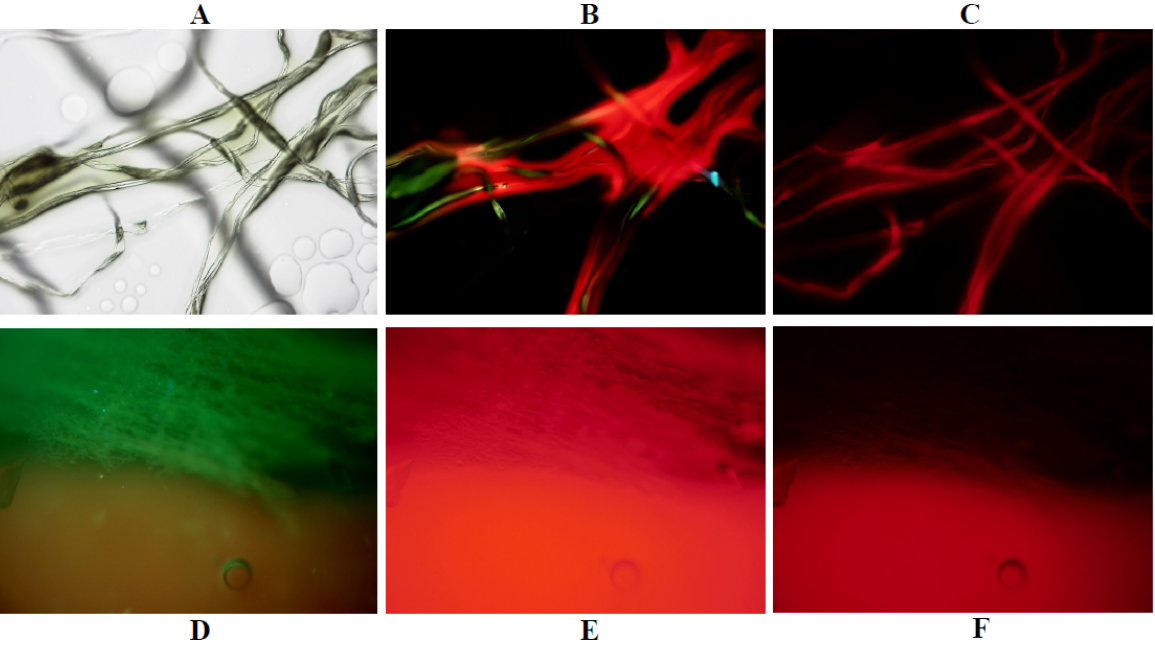
Figure 2. Phantom Experiments. ( A–C ): Cotton fibers were moistened with TPS and bovine serum. ( D–F ): Autofluorescence of PP IX from an iodine egg shell. ( A ): Image under white light; ( B ): Merged image under the PDD-B and PDD-A filters; ( C,F ): Under the Cy 5 filter; ( D ): Under the PDD-B filter; ( E ): Under the PDD-A filter.